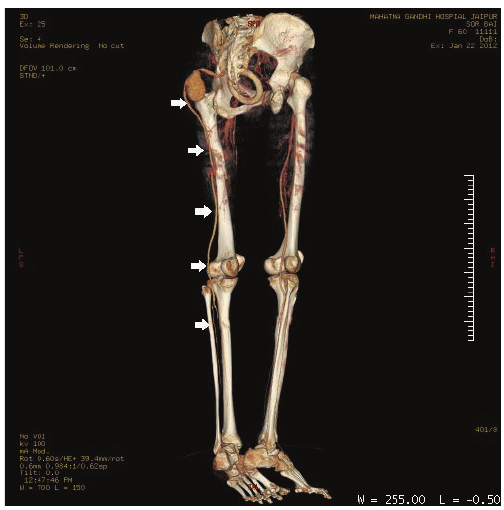
Figure 1: Left foot of the patient. The arrows depict gangrene of the 1st and 2nd toes. Also note the cyanosis of the rest of toes and ischemic changes on the skin of the foot.